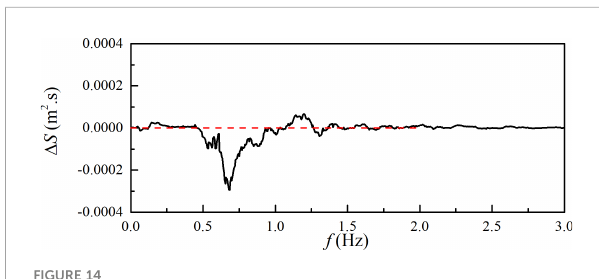
FIGURE 14 The difference of spectra between the stations 10 # and 8 # for case RJ 7